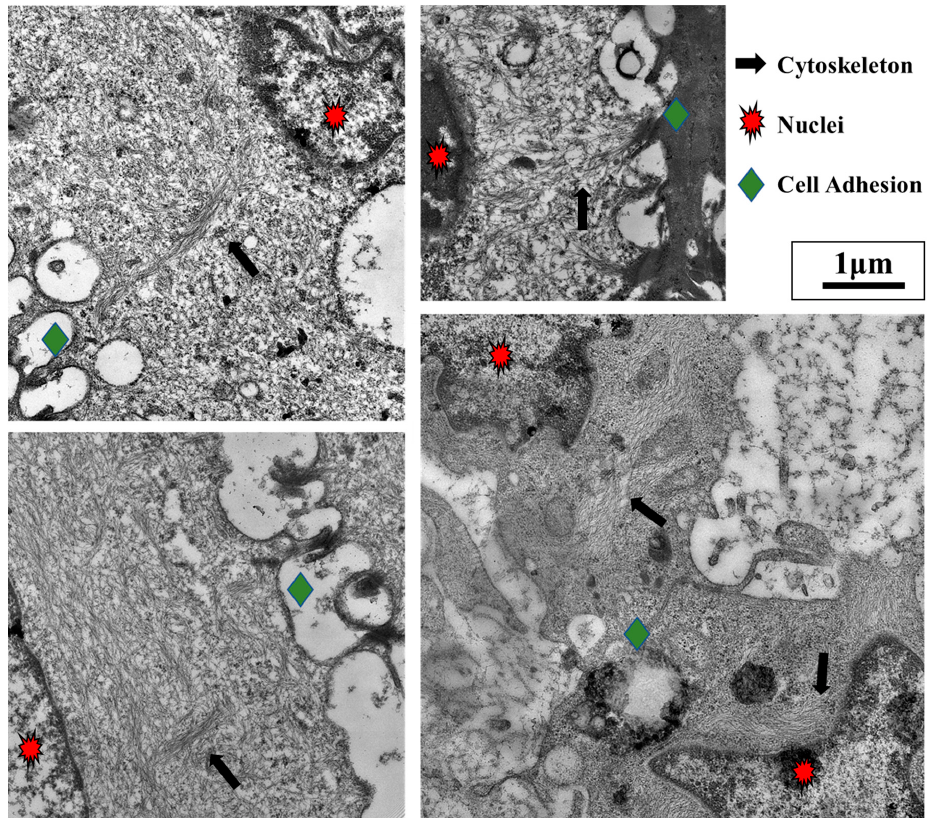
Figure 5. Cell adhesions to other cells and the extracellular matrix (ECM) are mechanically linked to the nucleus. Leukocytes and metastatic tumors often migrate to secondary lymphoid tissues. As seen from the lymphoid tissue images above, cells are intimately connected through several cell–cell adhesions ( green diamonds ) as they migrate and proliferate in this environment. The four images above show that cell adhesions ( green diamonds ) are directly linked to the nuclei ( red stars ) by cytoskeletal elements ( black arrows ). (Transmission electron microscopy images taken by our